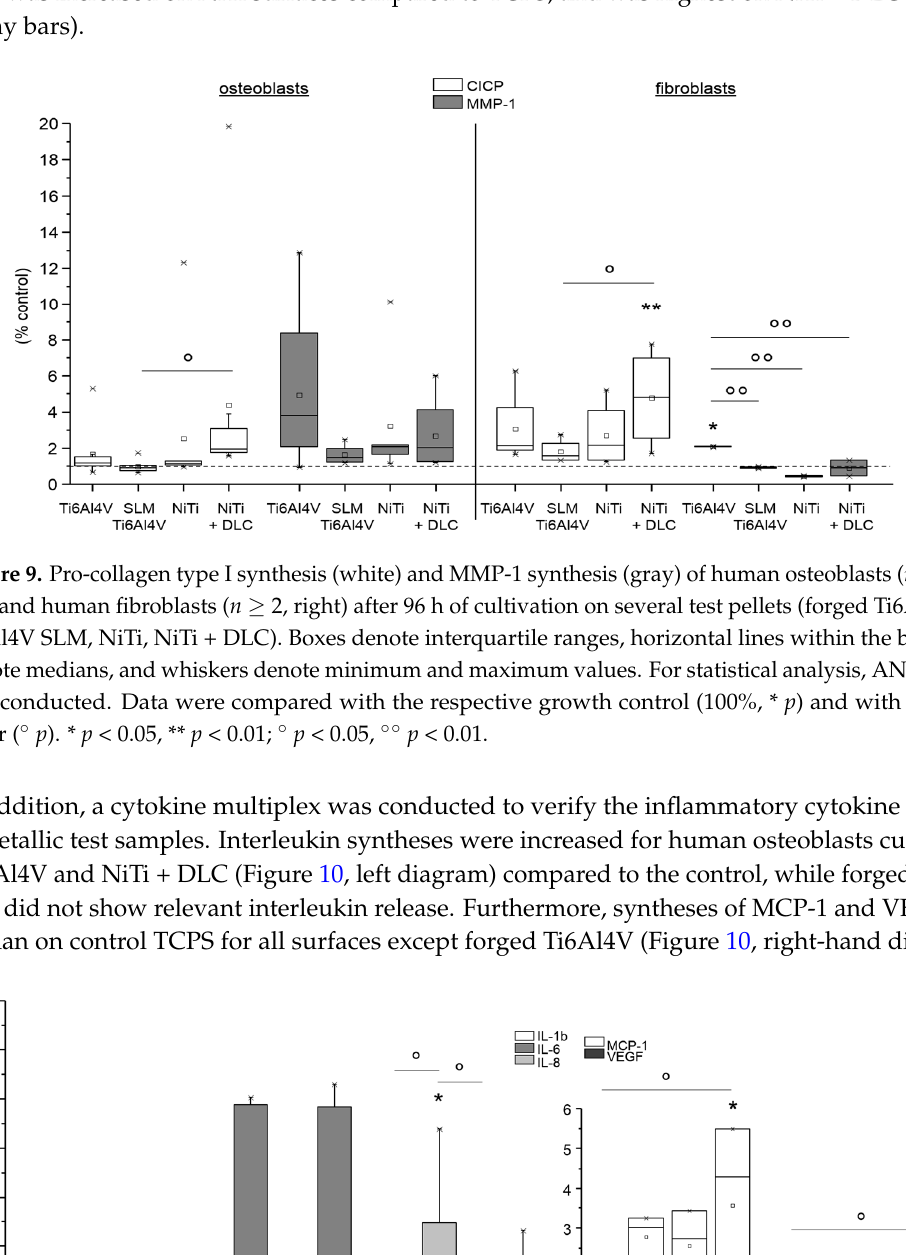
Figure 10. Cytokine level of IL-1b, IL-6, IL-8, MCP-1, and VEGF in supernatants of human osteoblasts ( n ≥ 2) after 96 h of cultivation on several test pellets (forged Ti6Al4V, Ti6Al4V SLM, NiTi, and NiTi + DLC). Data were normalized to the growth control (=100%, dotted line). Boxes denote interquartile ranges, horizontal lines within the boxes denote medians, and whiskers denote minimum and maximum values. For statistical analysis, ANOVA was conducted. A p -value < 0.05 was considered statistically significant. Comparison to growth control: * p < 0.05. Comparison between several test pellets: ° p < 0.05.